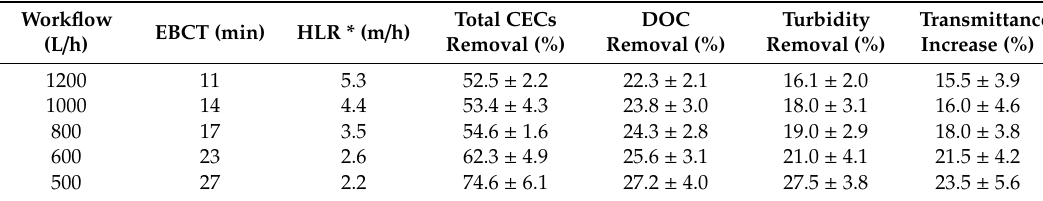
Table 4. CECs, dissolved organic carbon (DOC), turbidity and transmittance values obtained at different workflows ( n = 6).